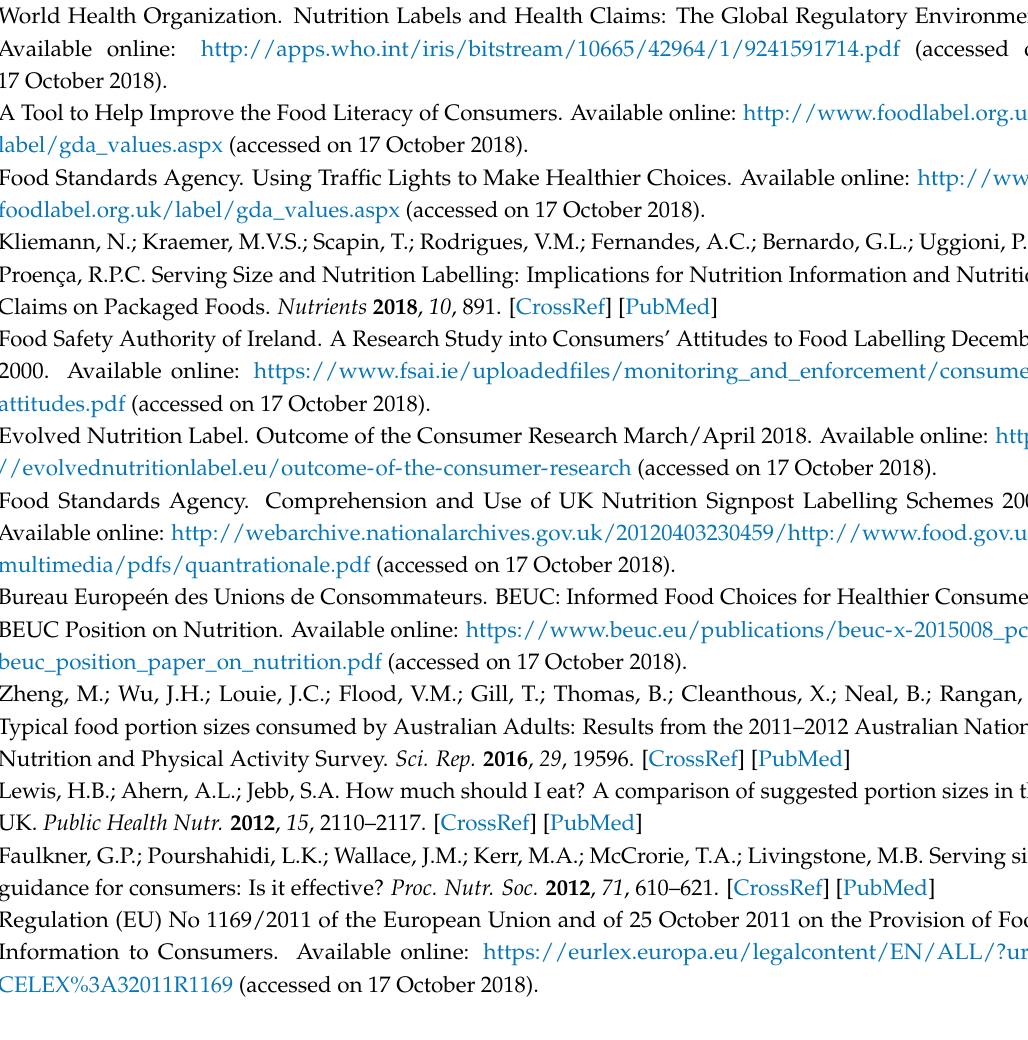
Table S1: Statistical aspects of the estimates of food portion size using median intakes from the NANS database for the two options for computing median intakes: population-based or